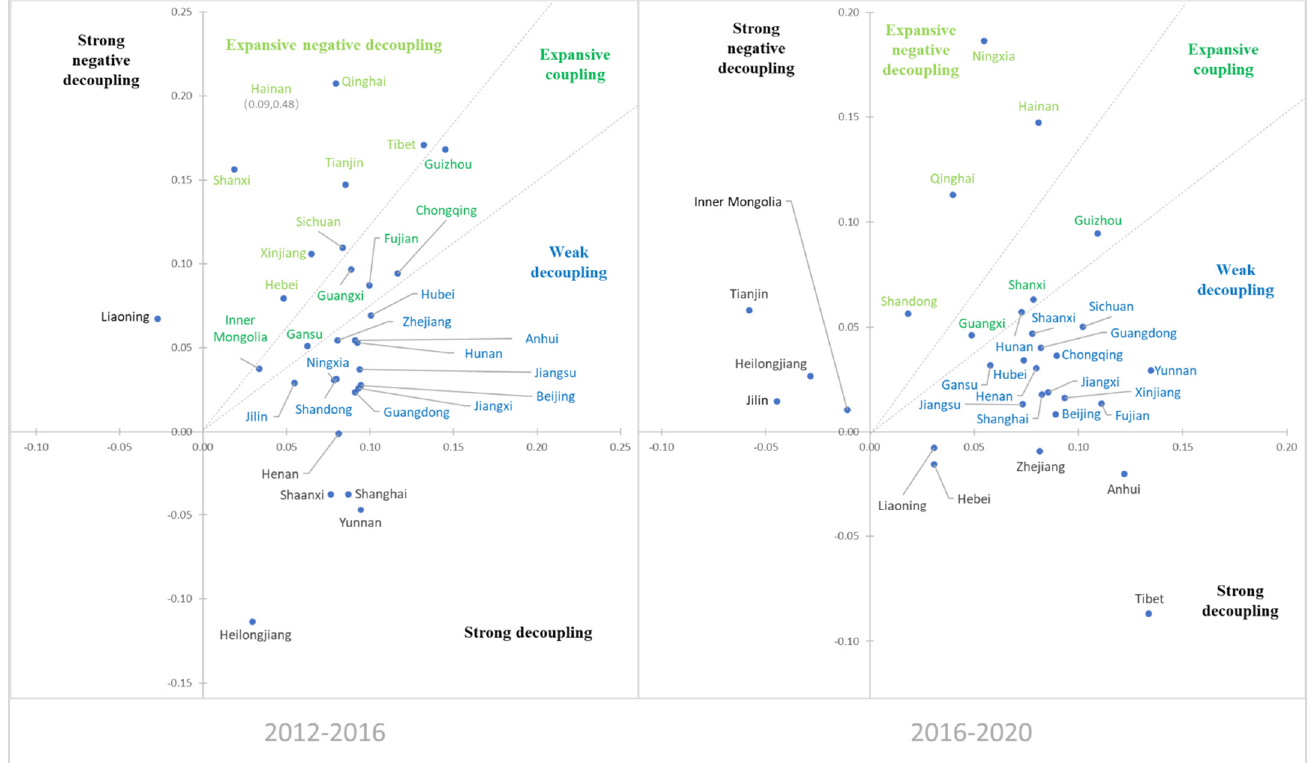
Figure 18. Analysis of effect of decoupling type on gross domestic product.